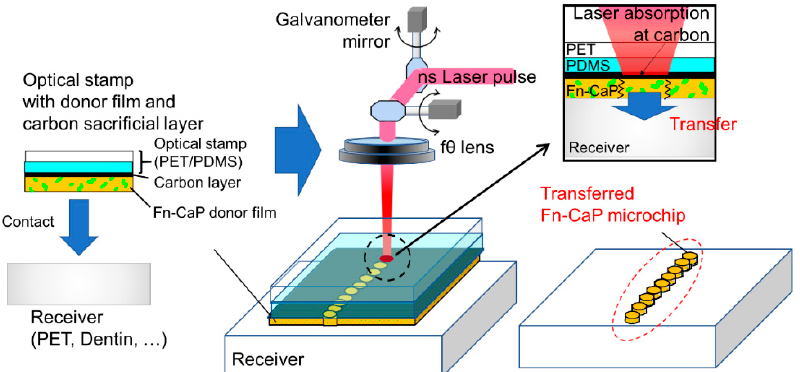
Figure 1. Schematic of the laser-induced forward transfer with optical stamp (LIFTOP) process. In the present work, the fibronectin-immobilized calcium phosphate (Fn-CaP) donor film was prepared on the carbon-coated optical stamp by the biomimetic process, which was then contacted with a receiver substrate (left). The irradiation of each nanosecond (ns) laser pulse caused strong laser absorption at the carbon sacrificial layer, leading to the donor film transfer onto the receiver substrate with a micropattern corresponding to the laser beam spot (right).